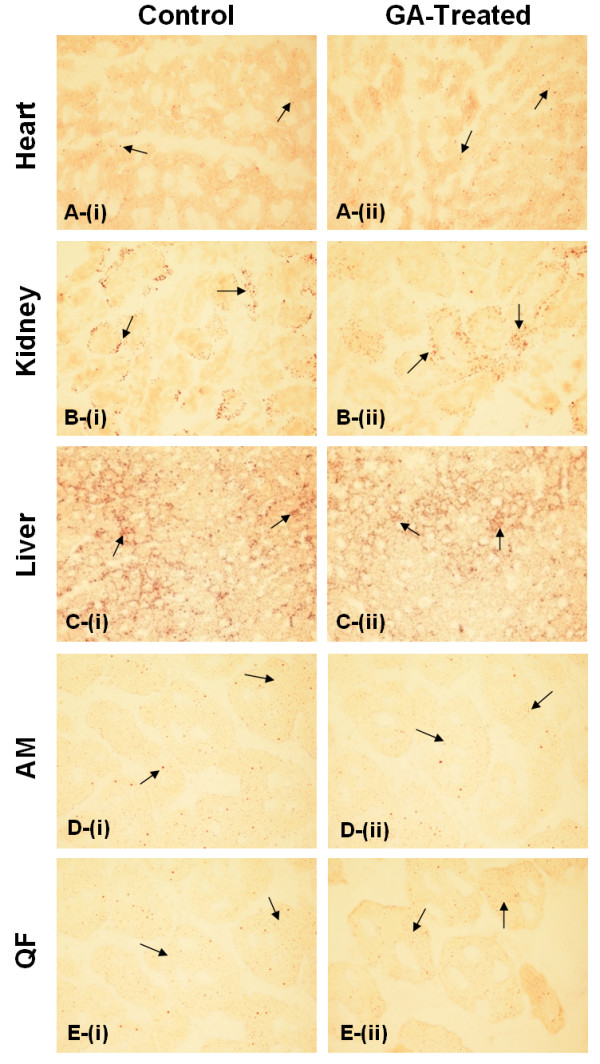
ORO-stained tissues. Representative sections of ORO-stained (A) heart, (B) kidney, (C) liver, (D) AM and (E) QF in (i) control and (ii) treated rats at 400× magnification. Distinct spots of ORO-stained lipid were observed across all tissue sections with considerable heterogeneity in lipid content between tissues. Arrows indicate examples of lipid droplets.